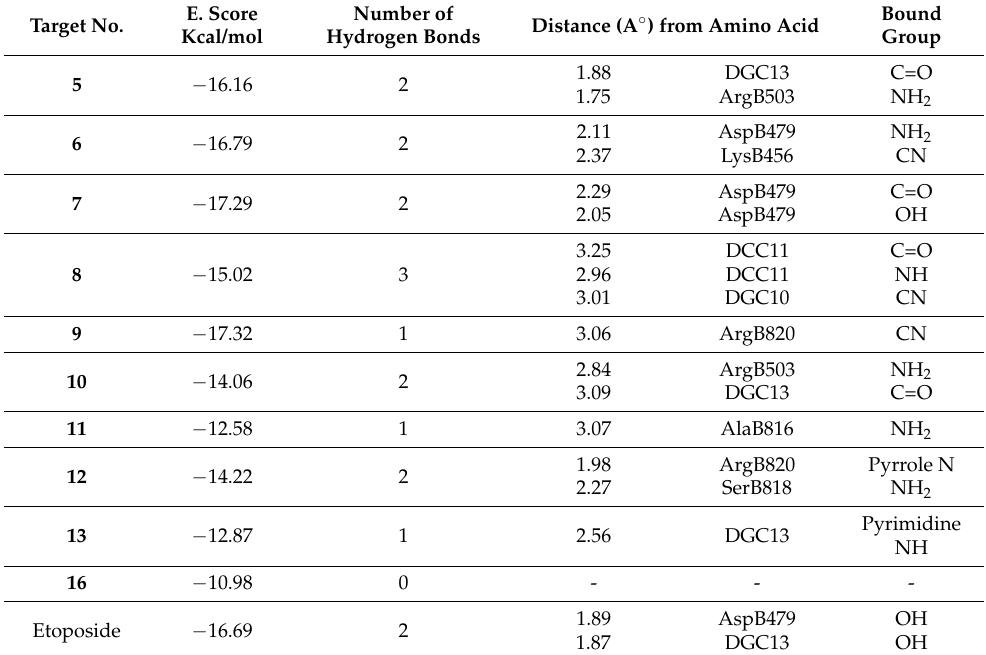
Table 2. Docking outcomes for compounds 5 – 13 , 16 and etoposide within topoisomerase II (code: 3QX3). Target